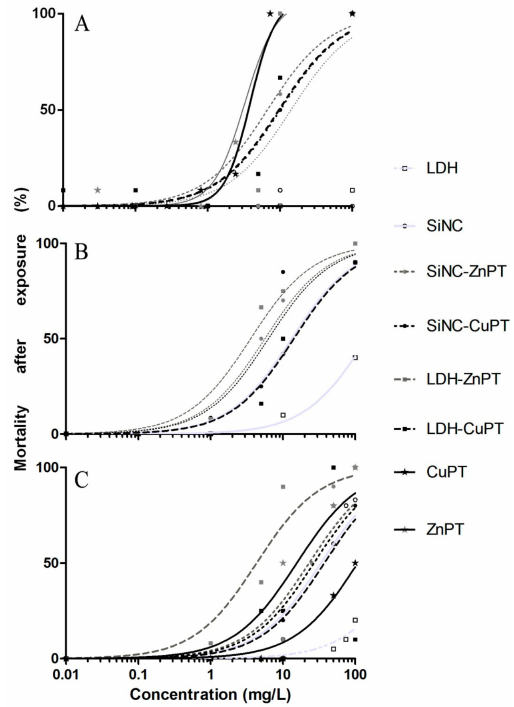
Figure 2. Mortality of the Atlantic mussel Mytilus galloprovincialis (( A ), ATL), and of Brachidontes pharaonis from the Mediterranean Sea (( B ), MED) and the Red Sea (( C ), RED) in efficacy assays following exposure to different concentrations of ENMs. ZnPT and CuPT for MED are not